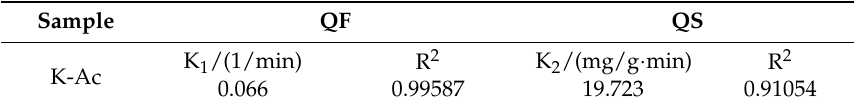
Table 2. The kinetic parameters of the quasi-first-order (QF) and quasi-second-order (QS) models on the adsorption of Cd 2+ .